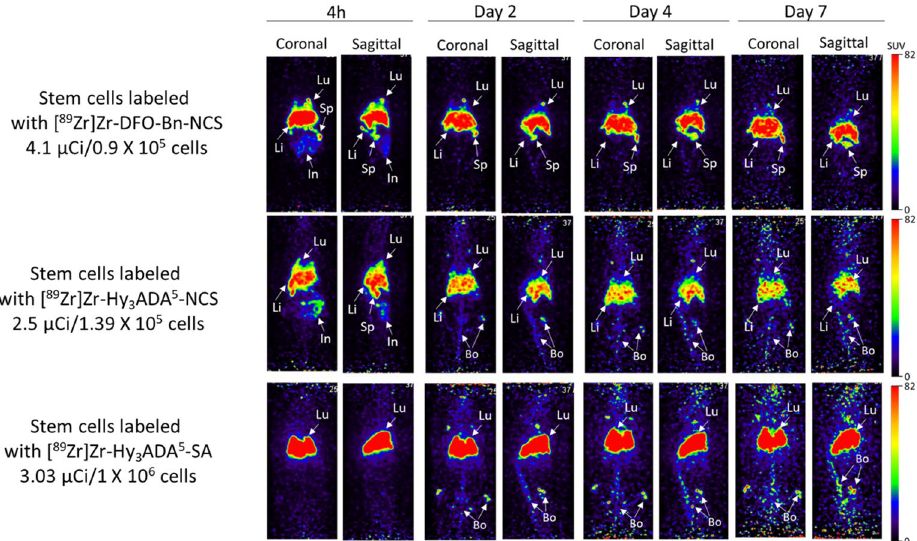
Figure 8. Representative coronal and sagittal PET maximum intensity projection (MIP) images showing distribution of stem cells labeled with [ 89 Zr]Zr-DFO-NCS, [ 89 Zr]Zr-Hy 3 ADA 5 -NCS and [ 89 Zr]Zr-Hy 3 ADA 5 -SA synthons in athymic nude mice at different time points post-injection.